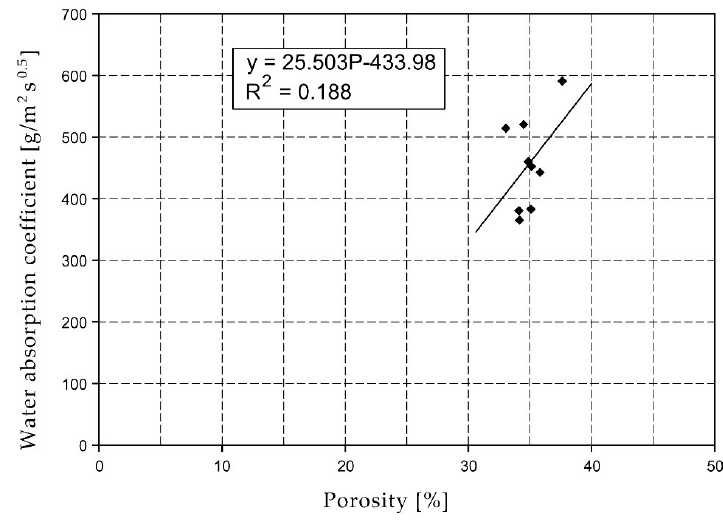
Figure 12. Compressive strength of O07XX series bricks.